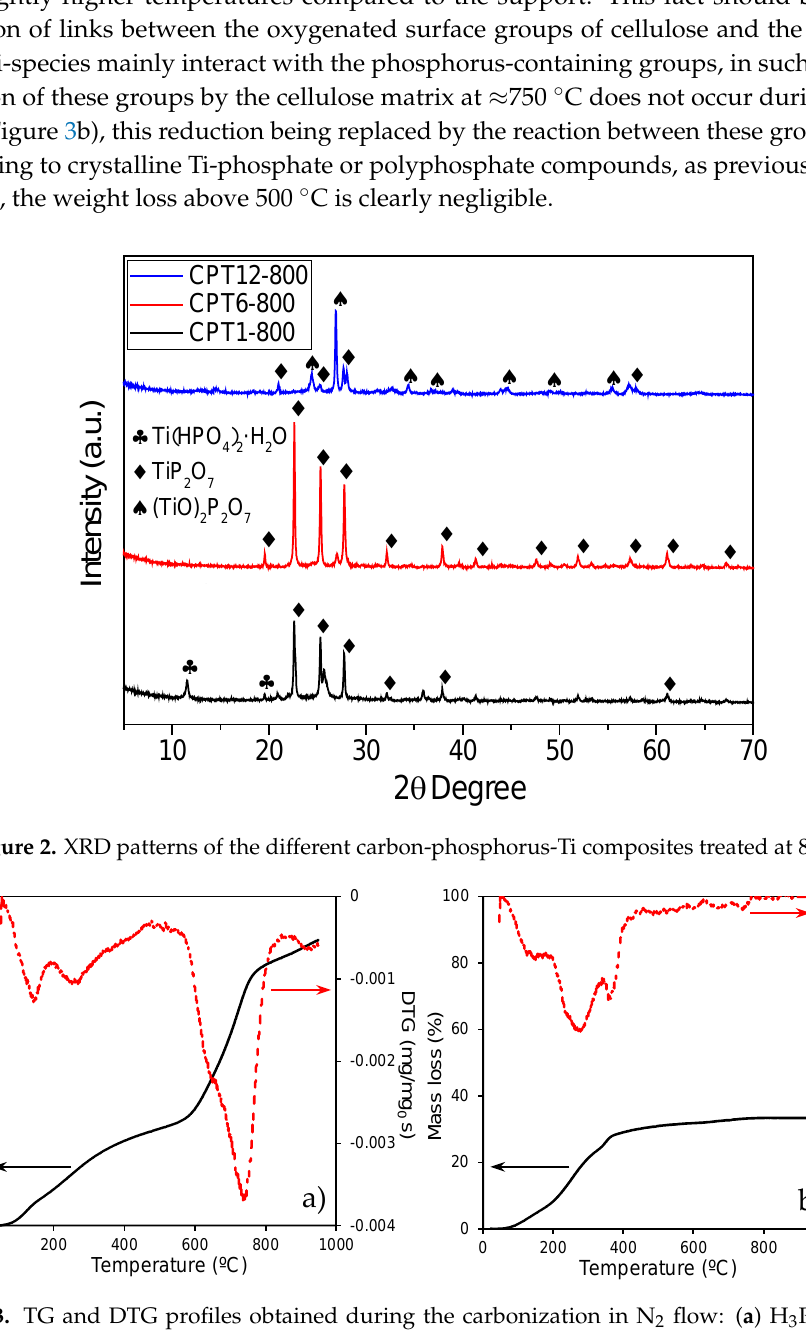
Figure 3. TG and DTG profiles obtained during the carbonization in N 2 flow: ( a ) H 3 PO 4 -treated cellulose support and ( b ) CPT6 composite.